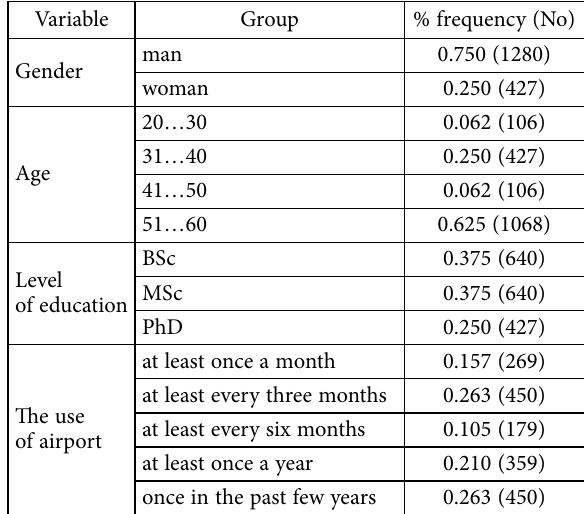
Table 1. Demographics of the